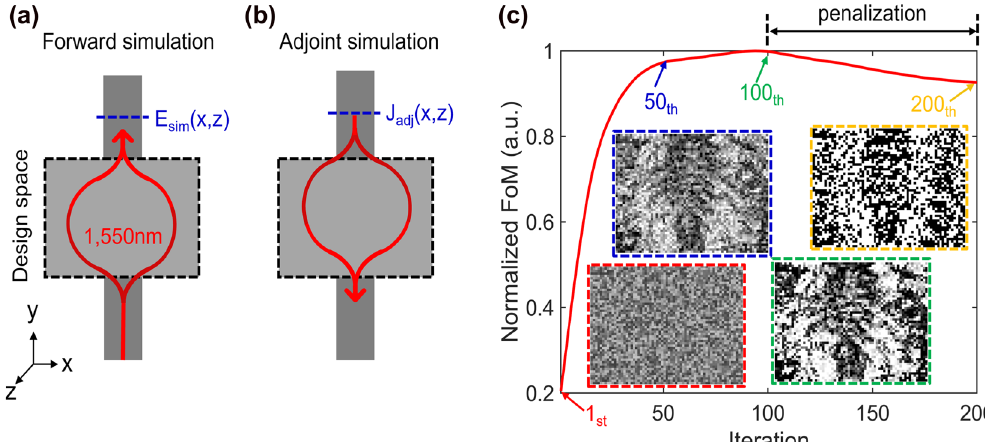
Figure 5: Schematic overview of the inverse design process. The integrated sensor structure consists of one input and output channel. ( x , z ) field distribution is (a) Forward simulation assumes a single fundamental mode excited in the input bus waveguide, while E sim = − i 𝜔 P = − i 𝜔𝜕  ∕ 𝜕 E . (b) J ( x , z ) field is used to compute J is excited in the output calculated in the output bus waveguide. Then, E sim adj adj adj bus waveguide and backpropagates through the design space. (c) A normalized figure of merit over the inverse design iterations. Until the figure of merit saturates, the design space is modeled as a grayscale structure, which can have spatial areas with effective dielectric properties intermediate between Si and air. Then, the penalization begins to binarize a grayscale shape to a Si-only structure amenable to lithographic fabrication. The inset structures (red, blue, green) indicate intermediate design parameters, while the yellow-dashed inset figure shows the optimized design